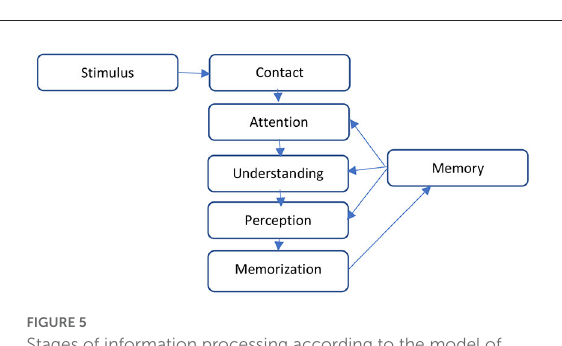
so on. It is much easier and more comfortable to do “like